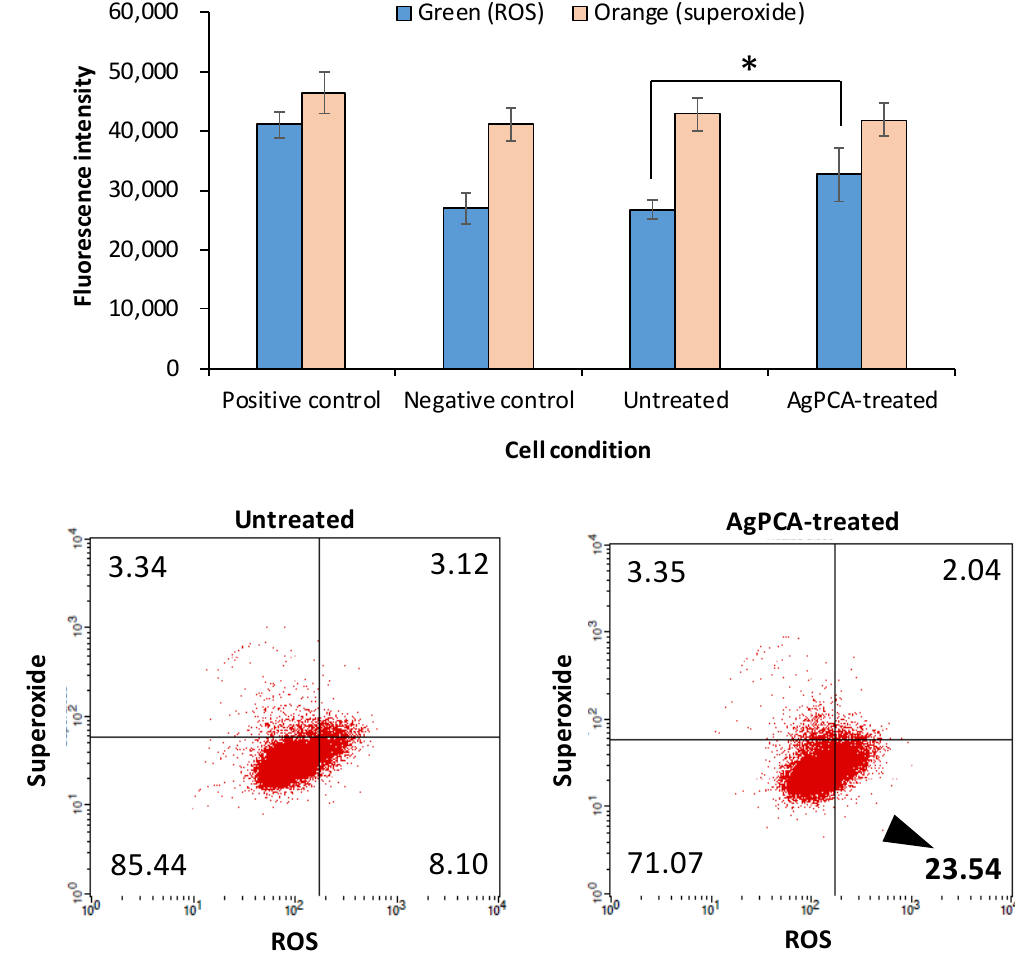
Figure 10. Reaction oxygen species (ROS) and superoxide production of untreated control and AgPCA-treated HCT116 cells. ( A ) Fluorescence intensity of green (ROS) and orange (superoxide). Data are expressed as mean + standard deviation for triplicates within an individual experiment. Statistical significance was performed using Student’s t test. (* p < 0.05). ( B ) Dot-plots by flow cytometry. Untreated cells were used as control. Cell debris were ungated. The numbers reflect the percentage of the cells in each quadrant and are represented by average of three independent experiments. Black triangle shows the increased level of ROS in AgPCA-treated cells.